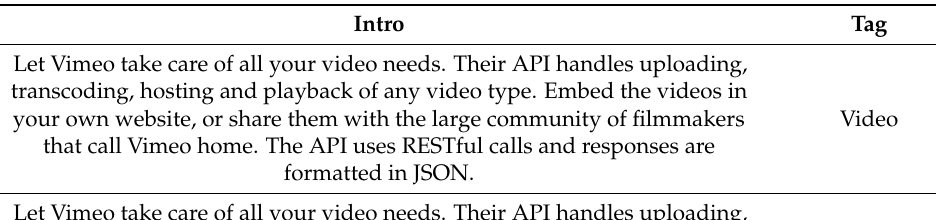
Table 3. Sample data in the Service Classification experiment.